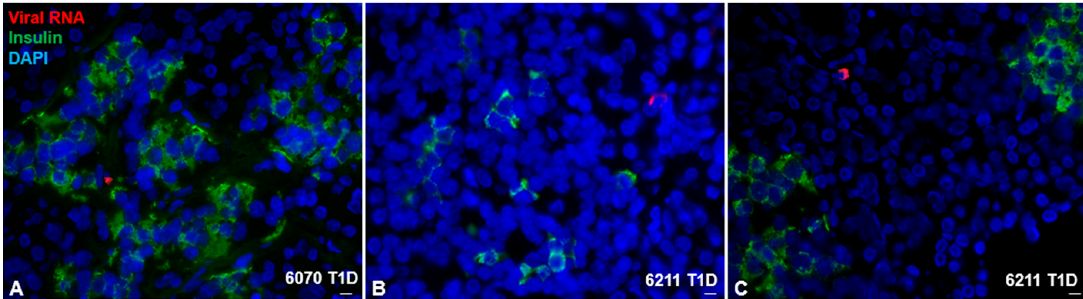
Figure 3. Coxsackieviral RNA in the T1D pancreas. Representative images of T1D donors 6070 and 6211 from the nPOD cohort. Viral RNA was found within the endocrine area ( A ) and outside the islets ( B , C ) shown by co-staining of viral RNA probes (red), insulin (green) and DAPI (nuclei; blue). Tissues were first probed for viral RNA, and then stained for insulin after a previously established protocol ([77]; Busse et al.). Scale bar depicts 10 µm.